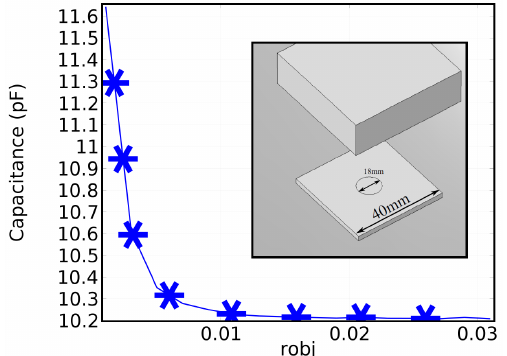
Figure 2. Simulation of the patch sensor and its capacitance change with the distance of an object. The patch has a radius of 9 mm, on FR4 substrate of a size of 40 mm × 40 mm and a thickness of 1.2 mm. Simulations are done in commercial software COMSOL